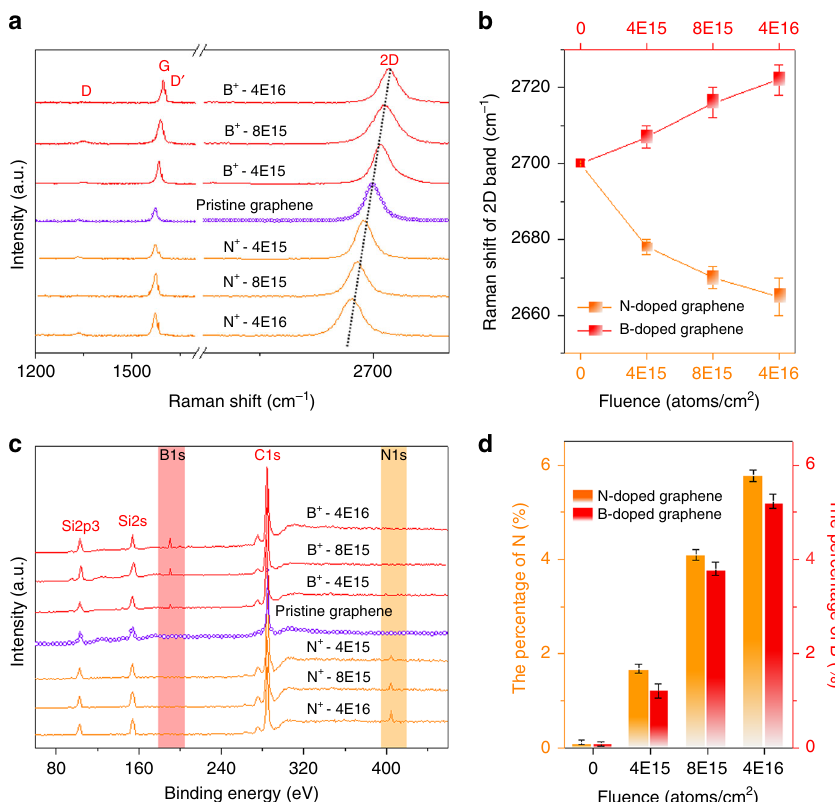
Fig. 2 Control of doping in the synthesis of B-doped and N-doped graphene. a Raman spectra of the B-doped and N-doped graphene fabricated using different ion implantation fl uences of B and N. b Shift in the 2D bands of B-doped and N-doped graphene as a function of ion implantation fl uence. c XPS spectra of B-doped and N-doped graphene fabricated using different ion implantation fl uences of B and N. d Histogram showing the atomic percentages of B and N in B-doped and N-doped graphene as a function of ion implantation fl